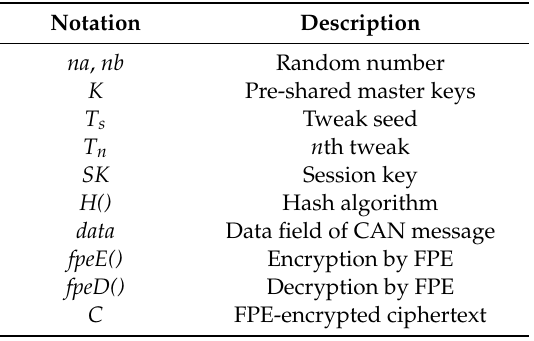
Table 3. Brief description of